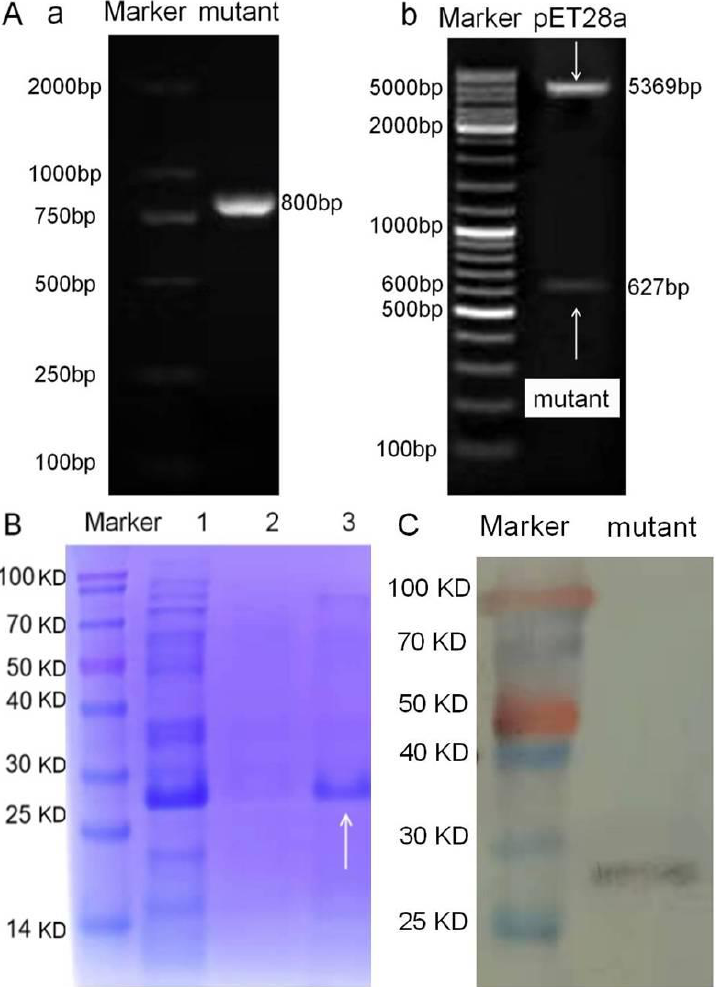
Figure 3. ( A ) Agarose gel electrophoresis results of ( a ) The TetR mutant (containing 6 × His-tag, about 170 bp) and ( b ) express vector pET28a-TetR mutant. ( B ) SDS-PAGE result of theTetR mutant (lane 1, bacterial whole protein; lane 2, purified inclusion body; lane 3, purified supernatant). ( C ) Western blotting result of theTetR mutant.